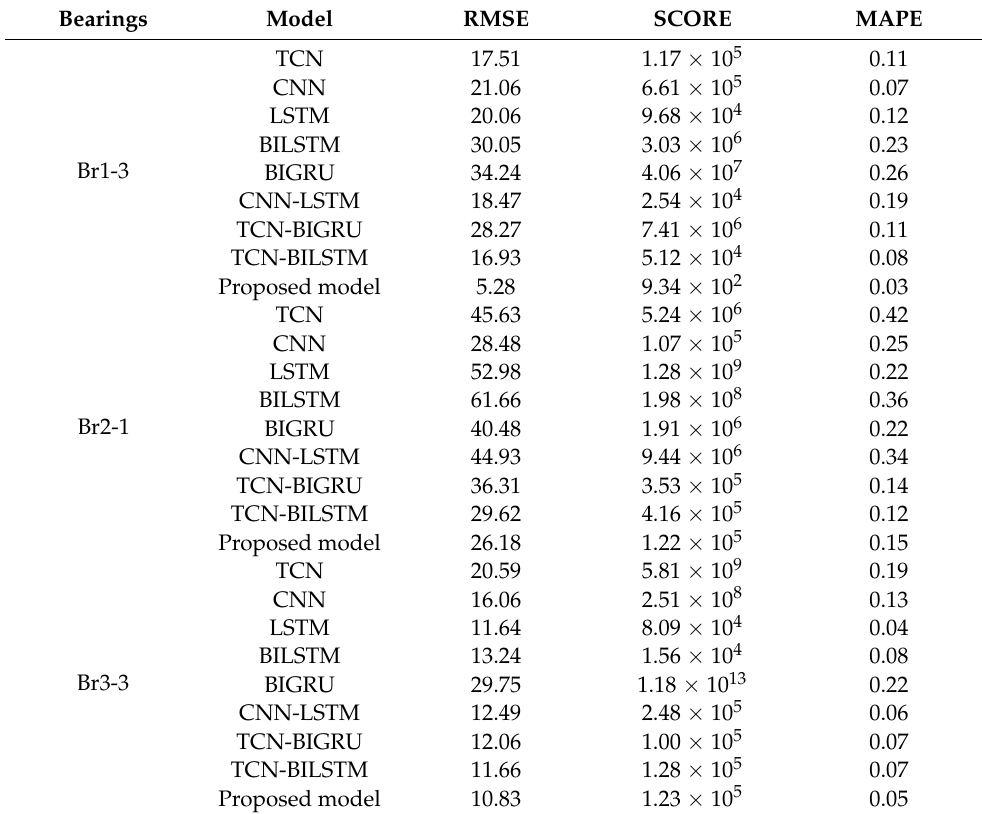
Table 7. Evaluation indexes for different